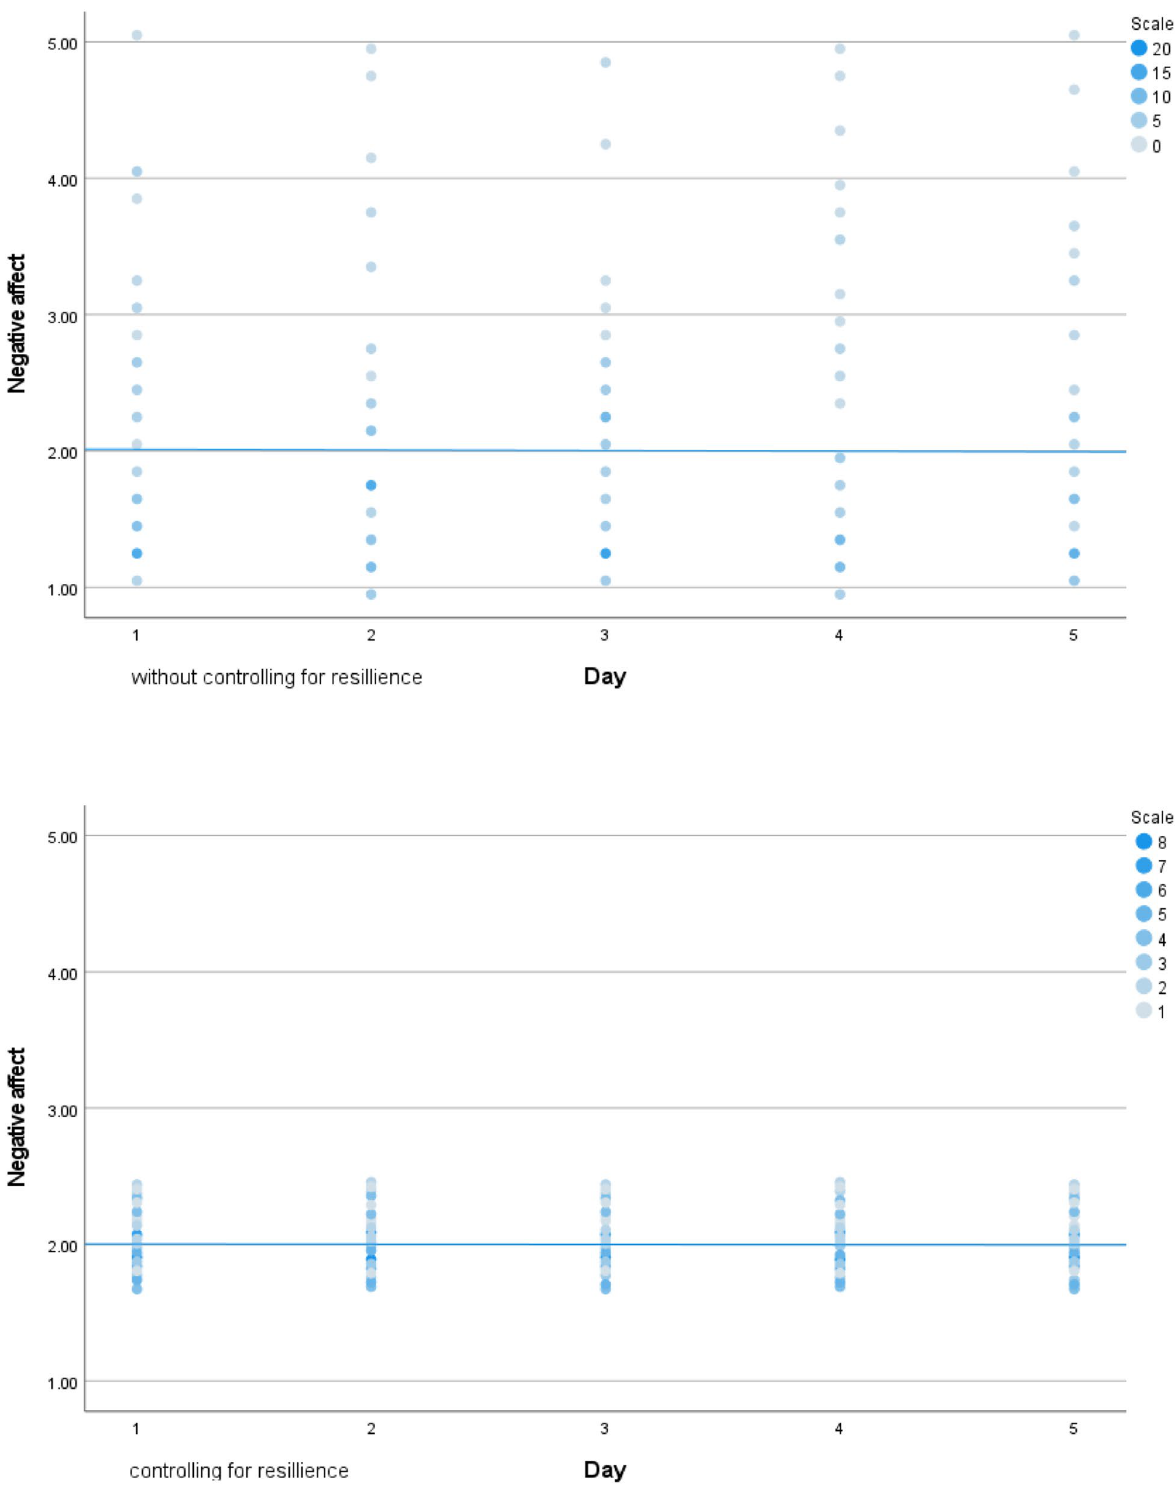
Figure 2. Variance in negative affect in five consecutive days without and with controlling for baseline resilience